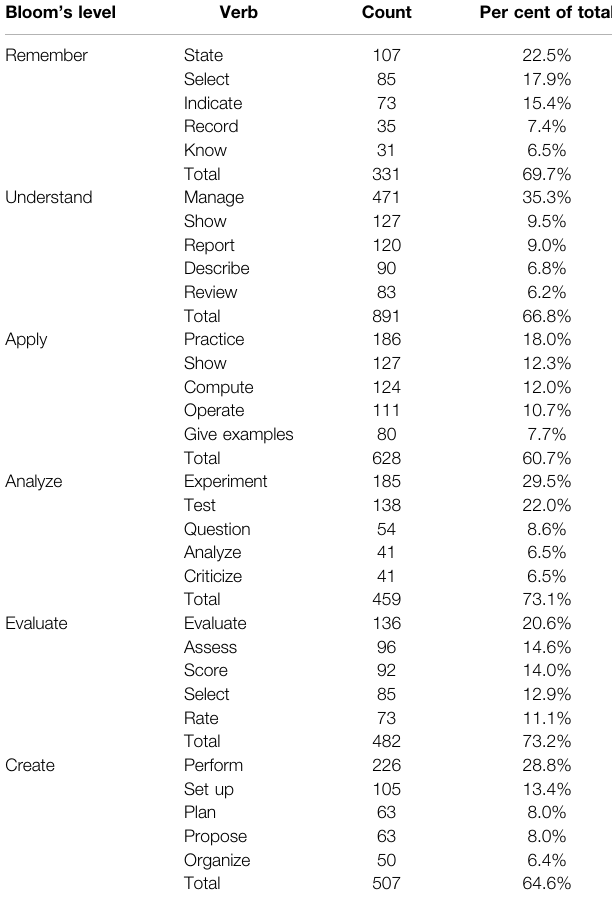
TABLE 3 | Absolute and relative frequencies of most frequently used Bloom ’ s Taxonomy verbs.